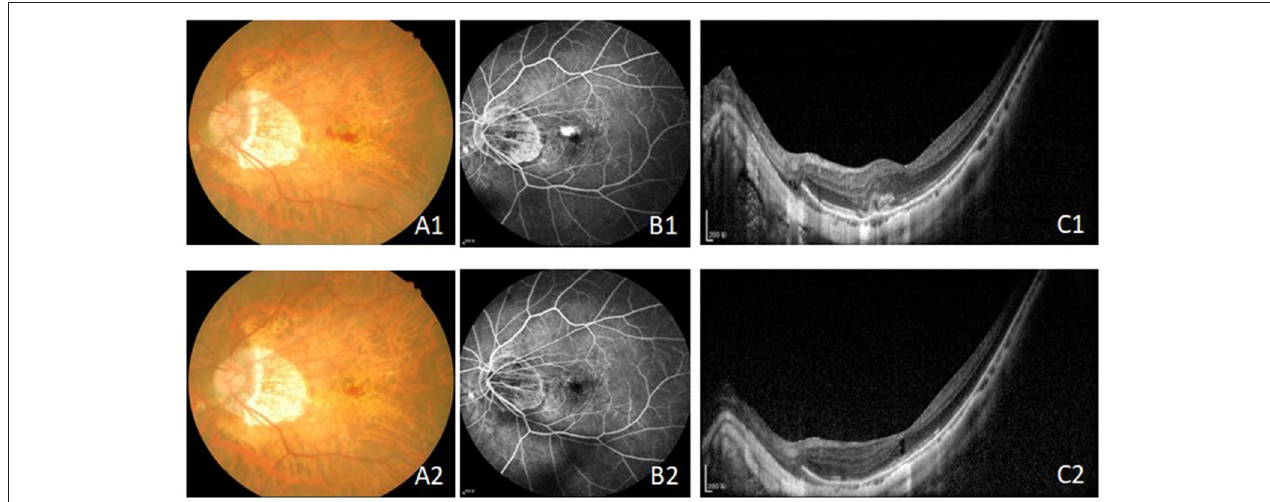
FIGURE 1 | The fundus, FFA and OCT results before (A1–C1) and after treatment (A2–C2) with intravitreal injection of conbercept in 6 month. The leakage of CNV were inhibited and the CRT and the CNV area were reduced. Bars = 200 µ m. FFA, fundus fluorescein angiography; OCT, optical coherence tomography; CRT, central retinal thickness; CNV, choroidal neovascularization.